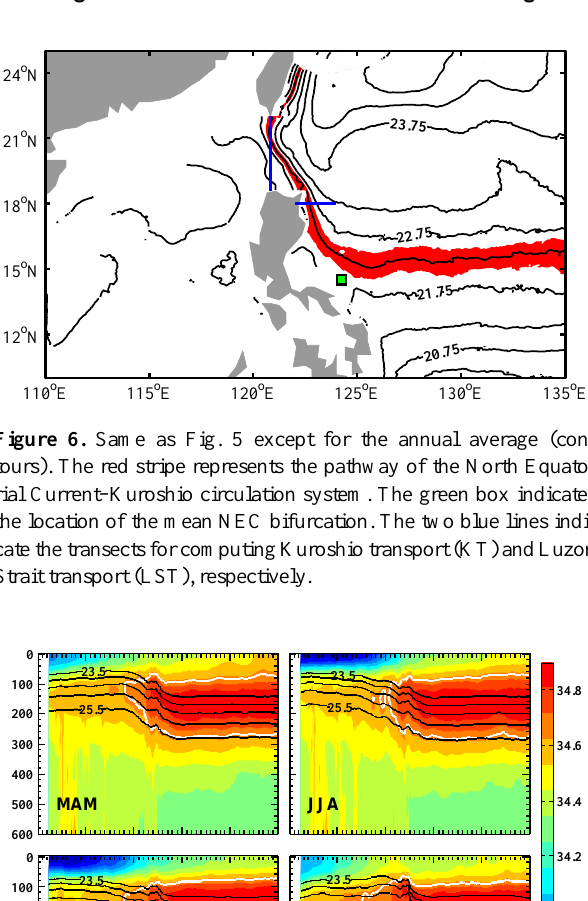
the LS is mainly confined to the upper 400 m between 20 and 21.3 ◦ N. While the outflow from the SCS to the western Pa- cific mainly occurs south of 20 ◦ N and north of 21.3 ◦ N, the inflow is relatively broader than the outflow and there exists significant seasonal variability that in winter is strongest and in summer is weakest. In the LS, the salinity maximum is mainly confined between 23.5 and 25.5 σ θ and the center